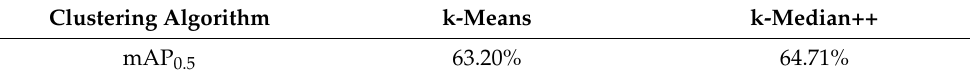
Table 4. Training results 1.